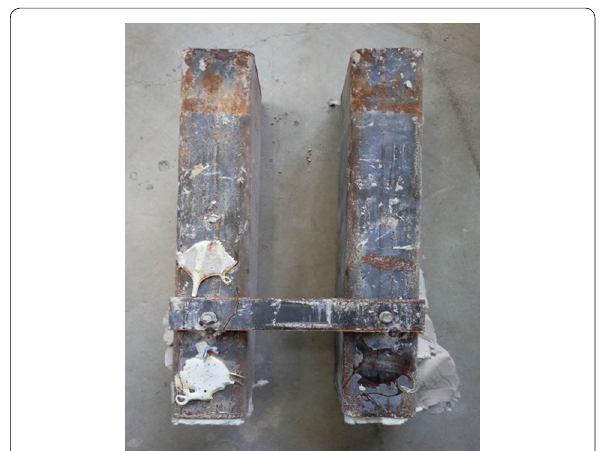
Fig. 7 Failure modes of Mode 1A and Mode 2.